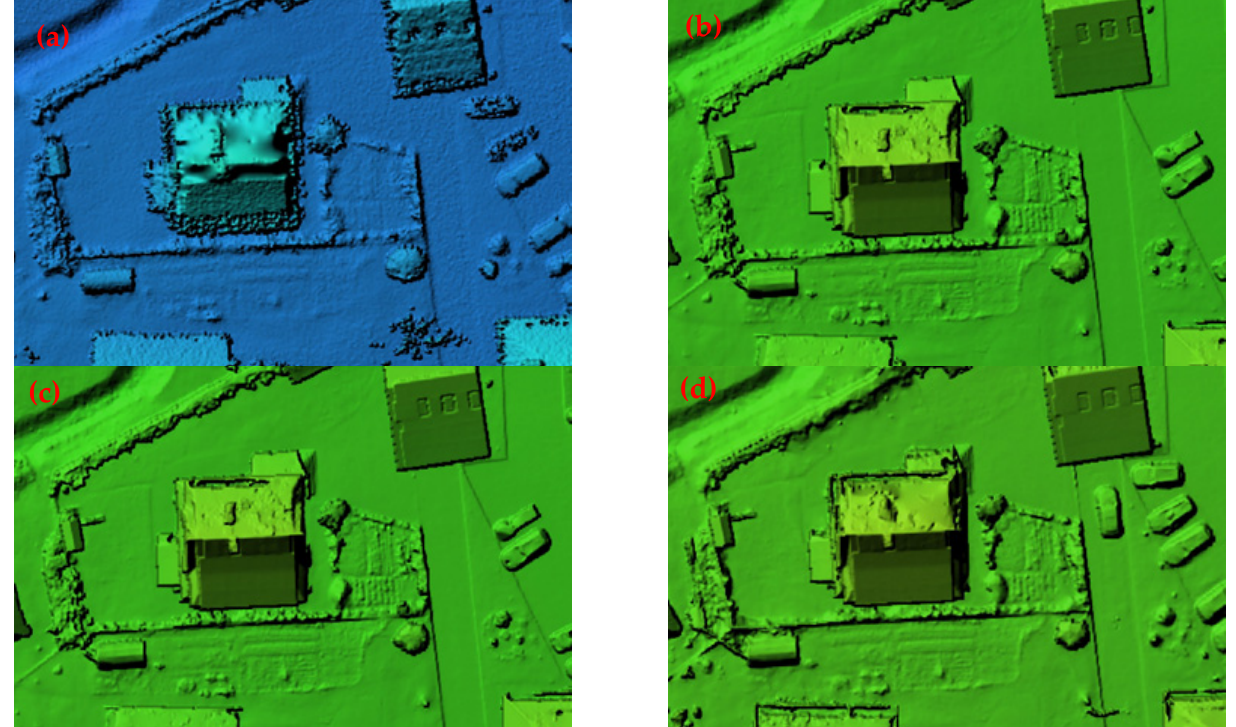
Figure 12. Comparison of DEM with a resolution of 0.1 m/pix ( a ) DEM generated from point clouds, L1 scanner ( b ) DEM generated from depth maps, P1 camera, DNG, ( c ) DEM generated from depth maps, P1 camera, TIF, ( d ) DEM generated from depth maps PSDK camera.